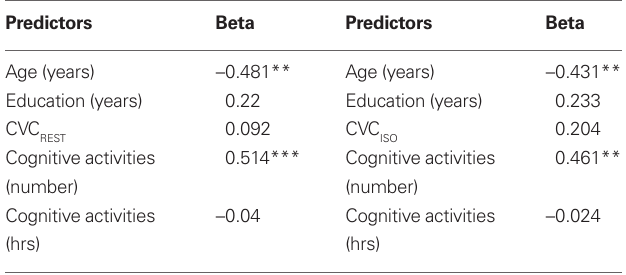
Table 6 | Summary of final significant model for prediction of global cognitive function when CVC variables are